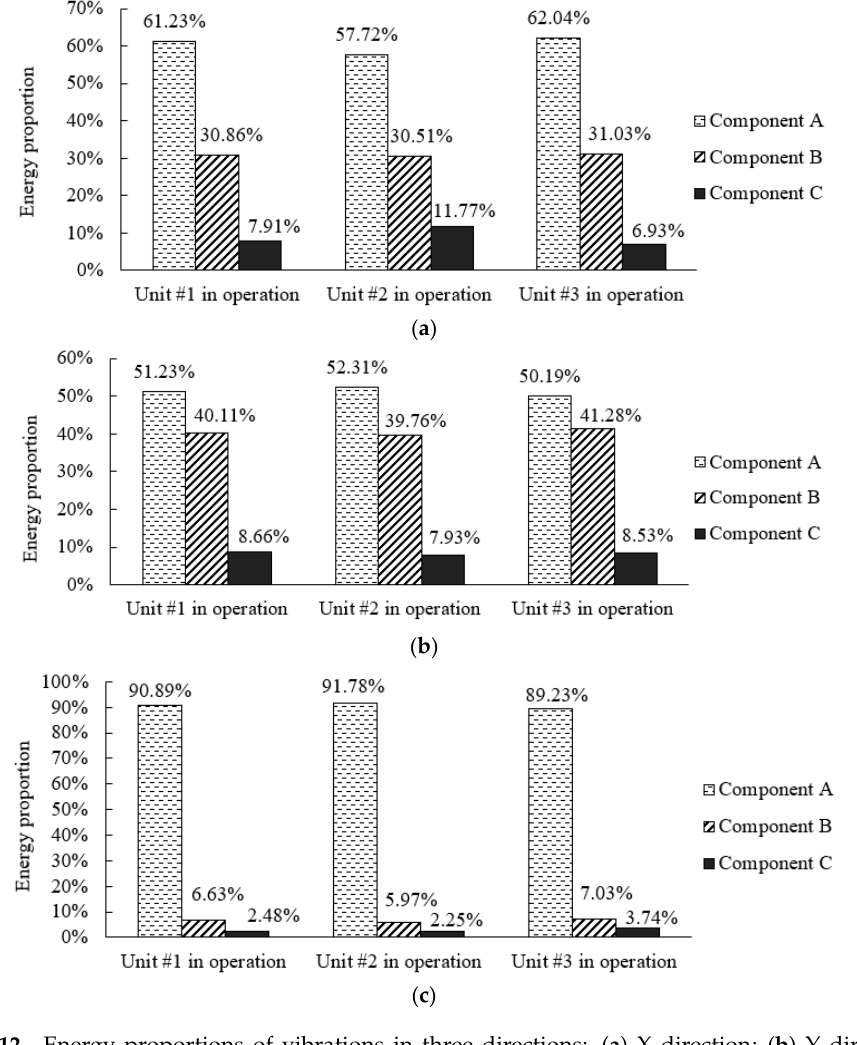
Figure 12. Energy proportions of vibrations in three directions: ( a ) X direction; ( b ) Y direction; and ( c ) Z direction.